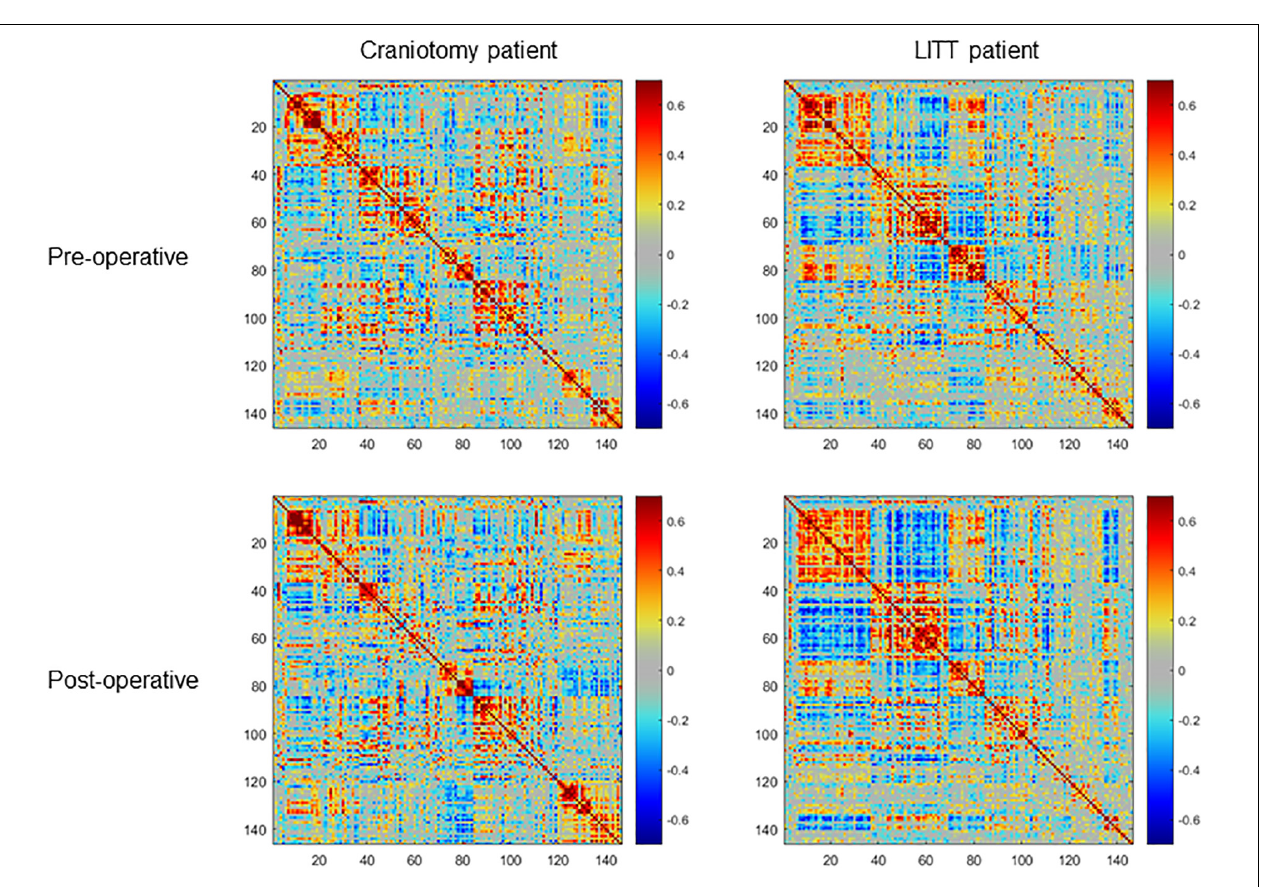
Frontiers in Neuroscience |